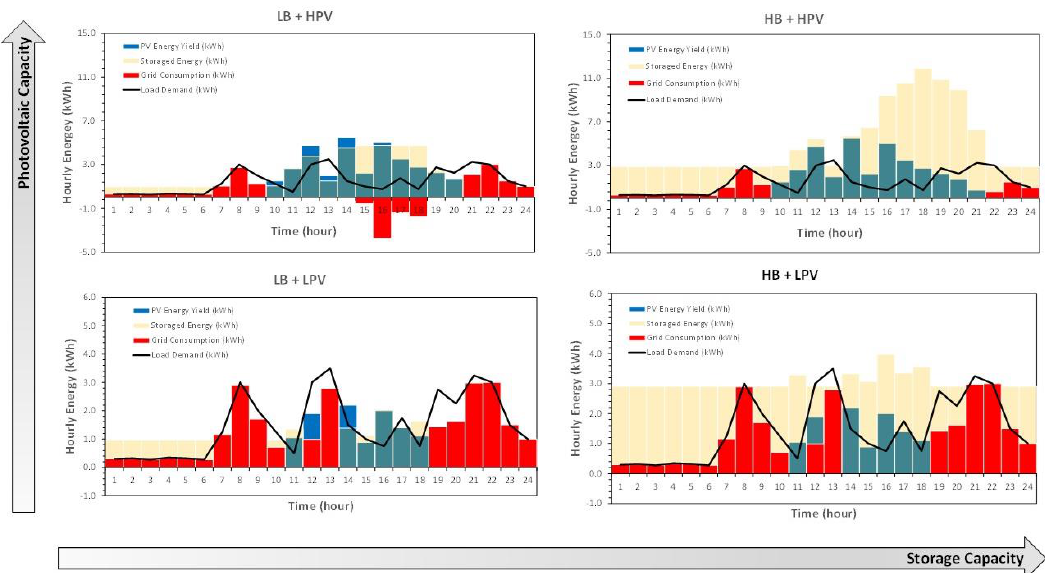
Figure 6. Daily energy balances according to the battery and PV system sizes for Cases 1 and 2. When the stored energy is lower than the PV, the energy yield in an hour, the bars show in a dark blue colour the PV energy yield and in light blue colour the stored energy. Otherwise, the PV energy yield is shown in a greenish-blue colour.